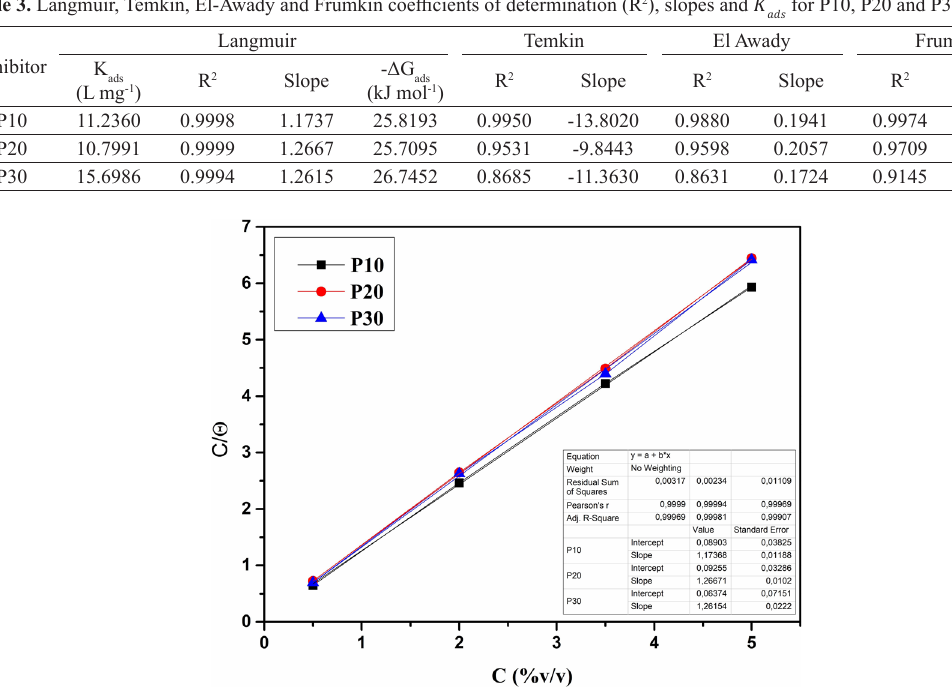
Figure 6. Langmuir adsorption isotherm for P10, P20 and P30 at 333 K.